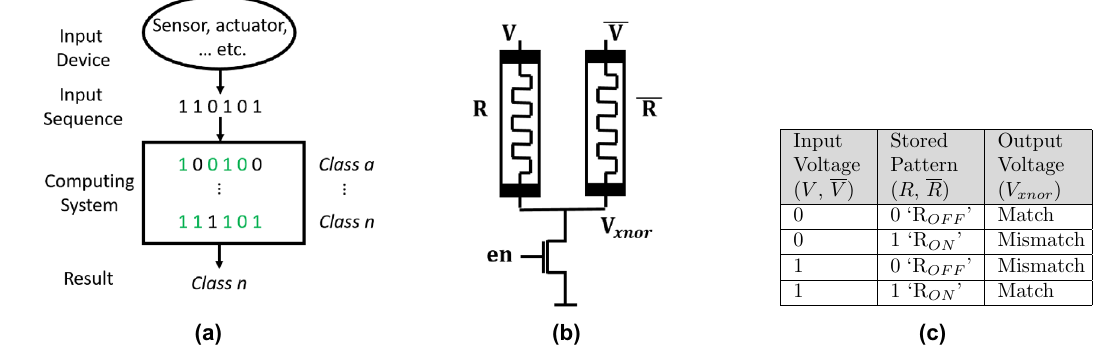
Figure 1. ( a ) Example of a computing system that naturally realizes in-memory search and match operations and determines the winning class. ( b ) A schematic of a two-input memristor VR-XNOR cell where one operand is voltage ( V , V ), and the second is resistance ( R , R ). V xnor is the output similarity voltage. The en configures the mode of operation of the XNOR cell. When en = 1 V, the cell is in write mode; otherwise, it will be in read mode. ( c ) Presents the associated XNOR Truth